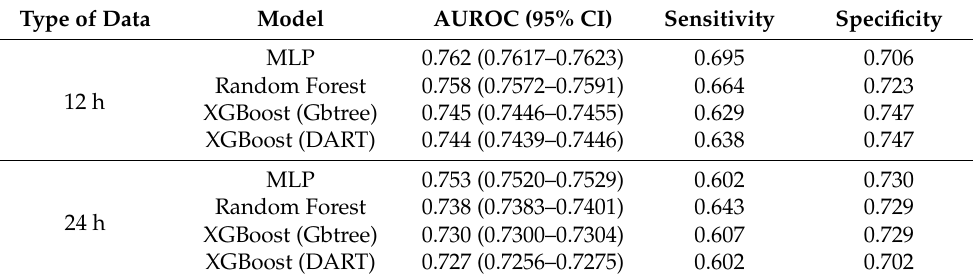
Table 1. Performance of predicting bacteremia using various machine learning methods.